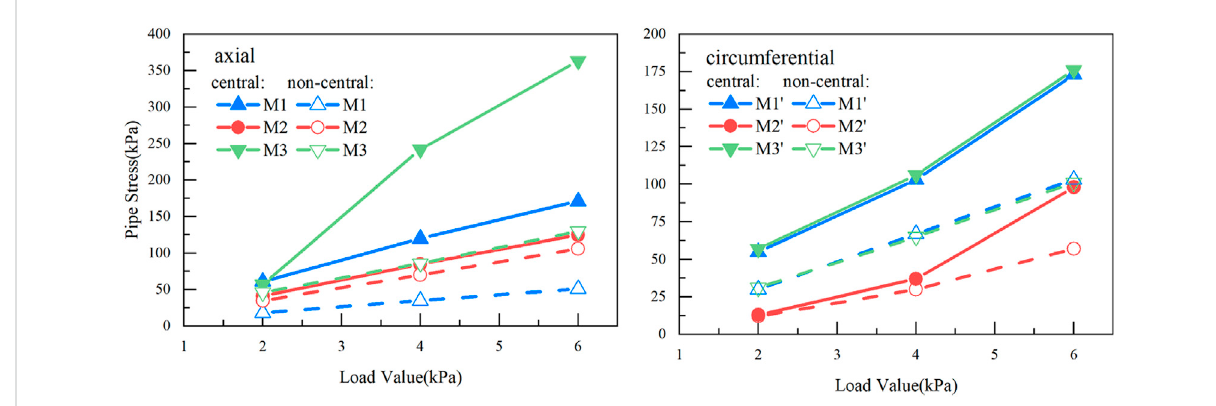
FIGURE 13 Comparison of the pipeline stress at section M under the central and non-central